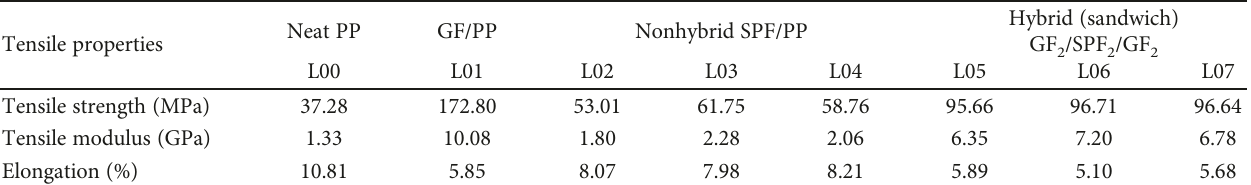
Table 4: Tensile properties of the hybrid and nonhybrid composites.